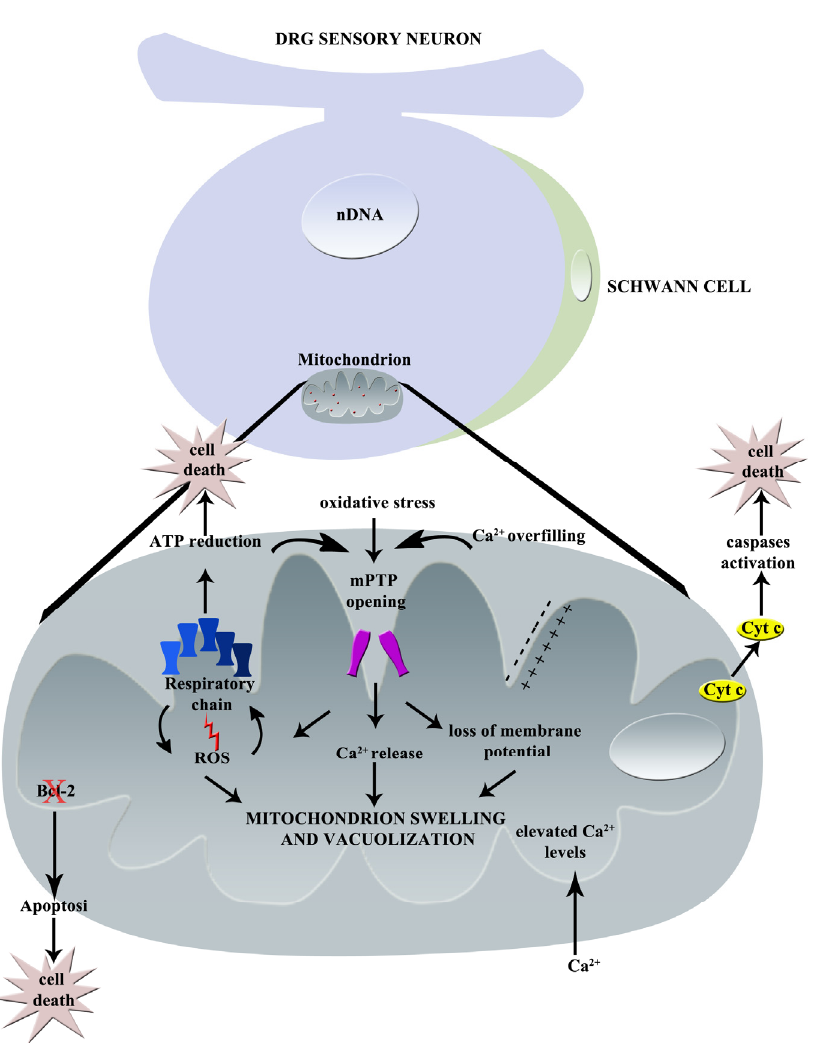
Figure 1. Graphical summary of paclitaxel-induced mechanisms of neurotoxicity: principal effects on mitochondrion (nDNA = nuclear DNA, mPTP = mitochondrial Permeability Transition Pore, Cyt c = Cytochrome C, Ca 2+ = calcium, ROS = Reactive Oxygen